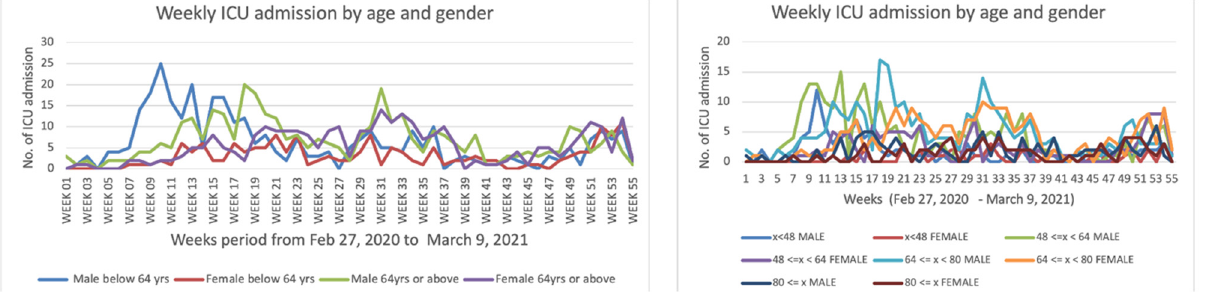
Figure 3. Curves of COVID-19 weekly ICU admissions in Kuwait by age classes (two on the left and four on the right ) and gender from 27 February 2020 to 9 March 2021.